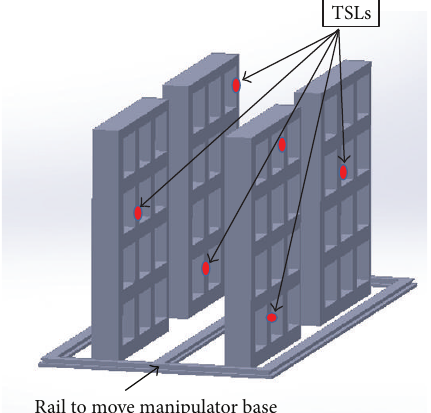
Figure 1: A server room environment with task space locations.